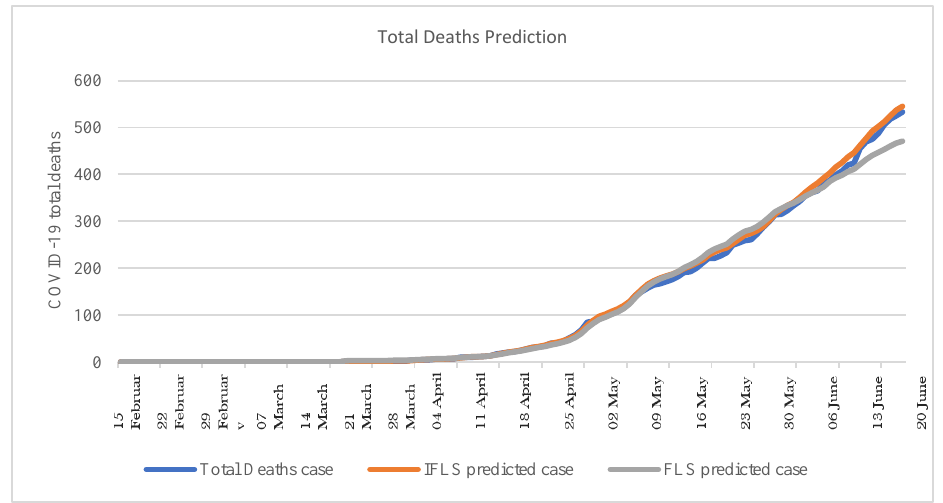
Fig. 8. Graph showing actual and predicted outputs of COVID-19 total cases.